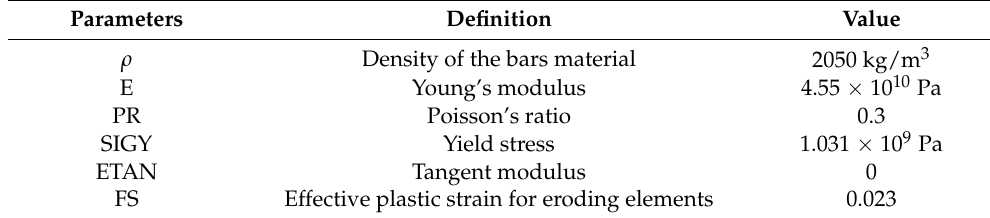
Table 5. Parameters of the BFRP bars material